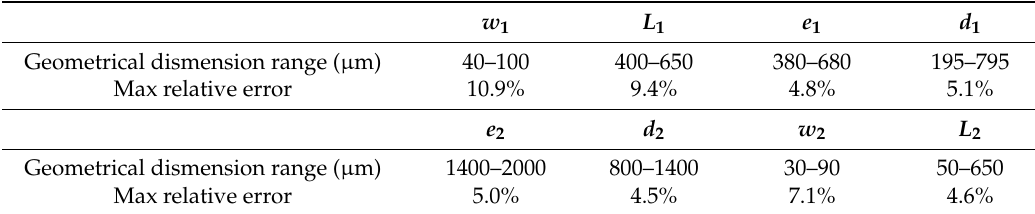
Table 2. The geometrical dimension ranges and maximum relative